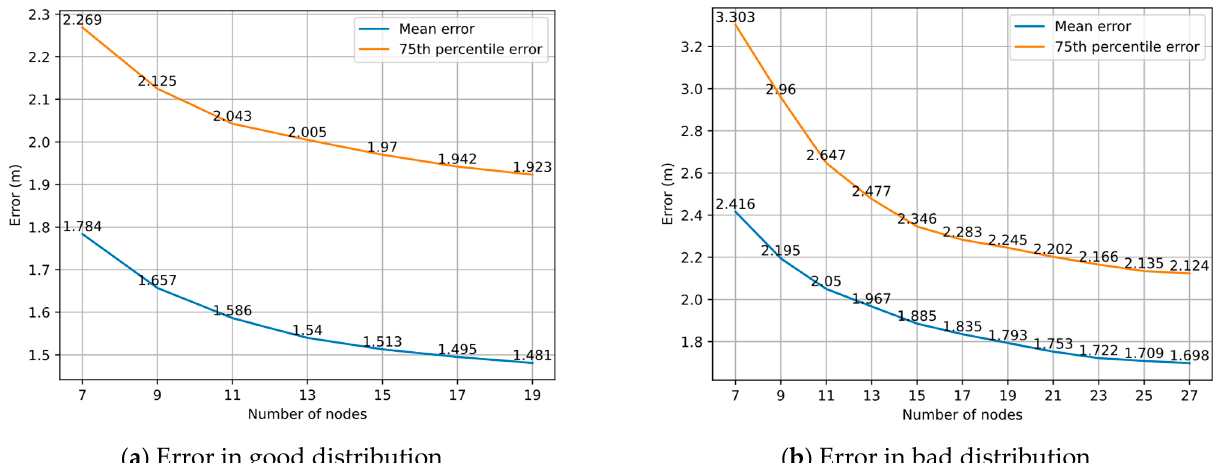
Figure 11. Positioning errors under different numbers of nodes in two types of distribution.